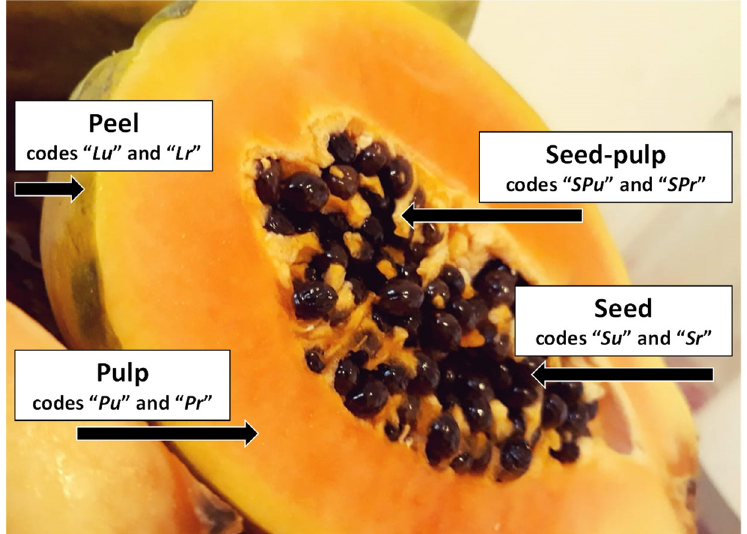
Figure 4. Representative image for the papaya parts used in this study: peel (the exterior of the fruit, codes “ Lu ” and “ Lr ” for the unripe and ripe papaya), pulp (the main core part, without the seeds region, codes “ Pu ” and “ Pr ” for the unripe and ripe fruit), seed (without the surrounding pulp, codes “ Su ” and “ Sr ” for the unripe and ripe fruit) and seed-pulp (the pulp from the seeds region, codes “ SPu ” and “ SPr ” for the unripe and ripe papaya).